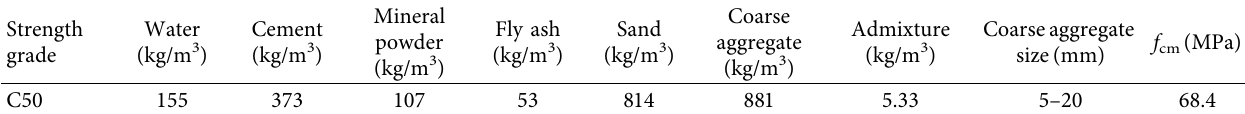
Table 2: Concrete mix proportions and 28-day compressive